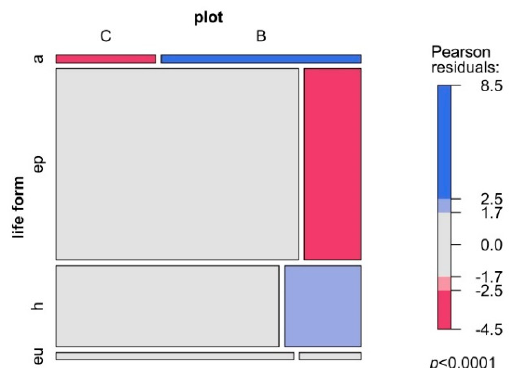
Figure 6. Mosaic plot of collembolan life form occurrence in control plots (C) and in plots bioturbated by wild boar (B). Life form code: a, atmobiotic; ep, epedaphic; h, hemiedaphic; eu, euedaphic.